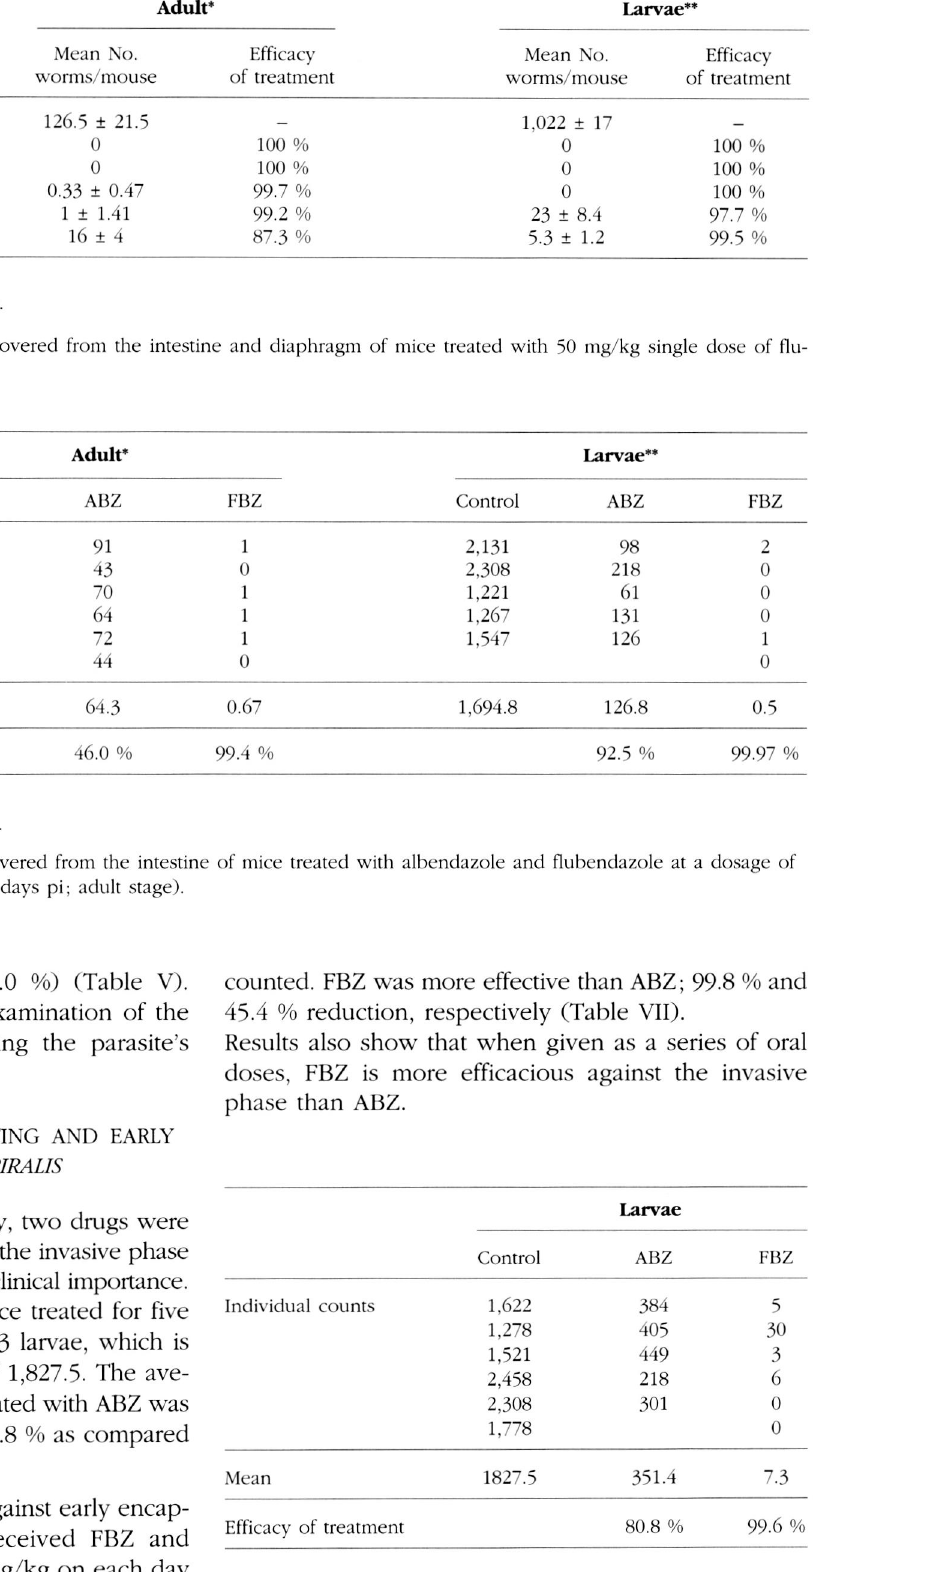
Table VI. - Number of T. spiralis larva recovered at 45 dpi from the diaphragm of mice treated with albendazole and flubendazole at